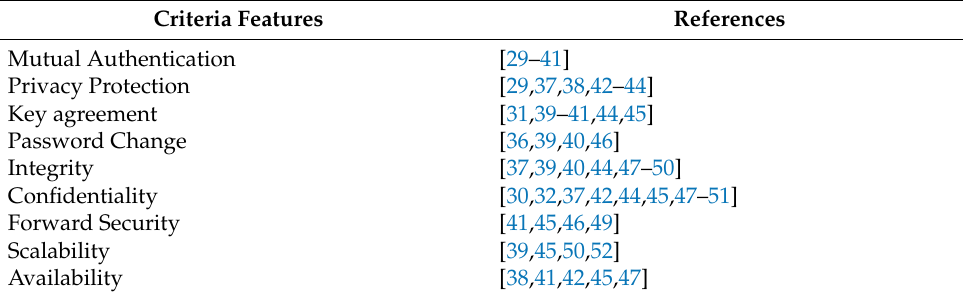
Table 1. Features Literature.